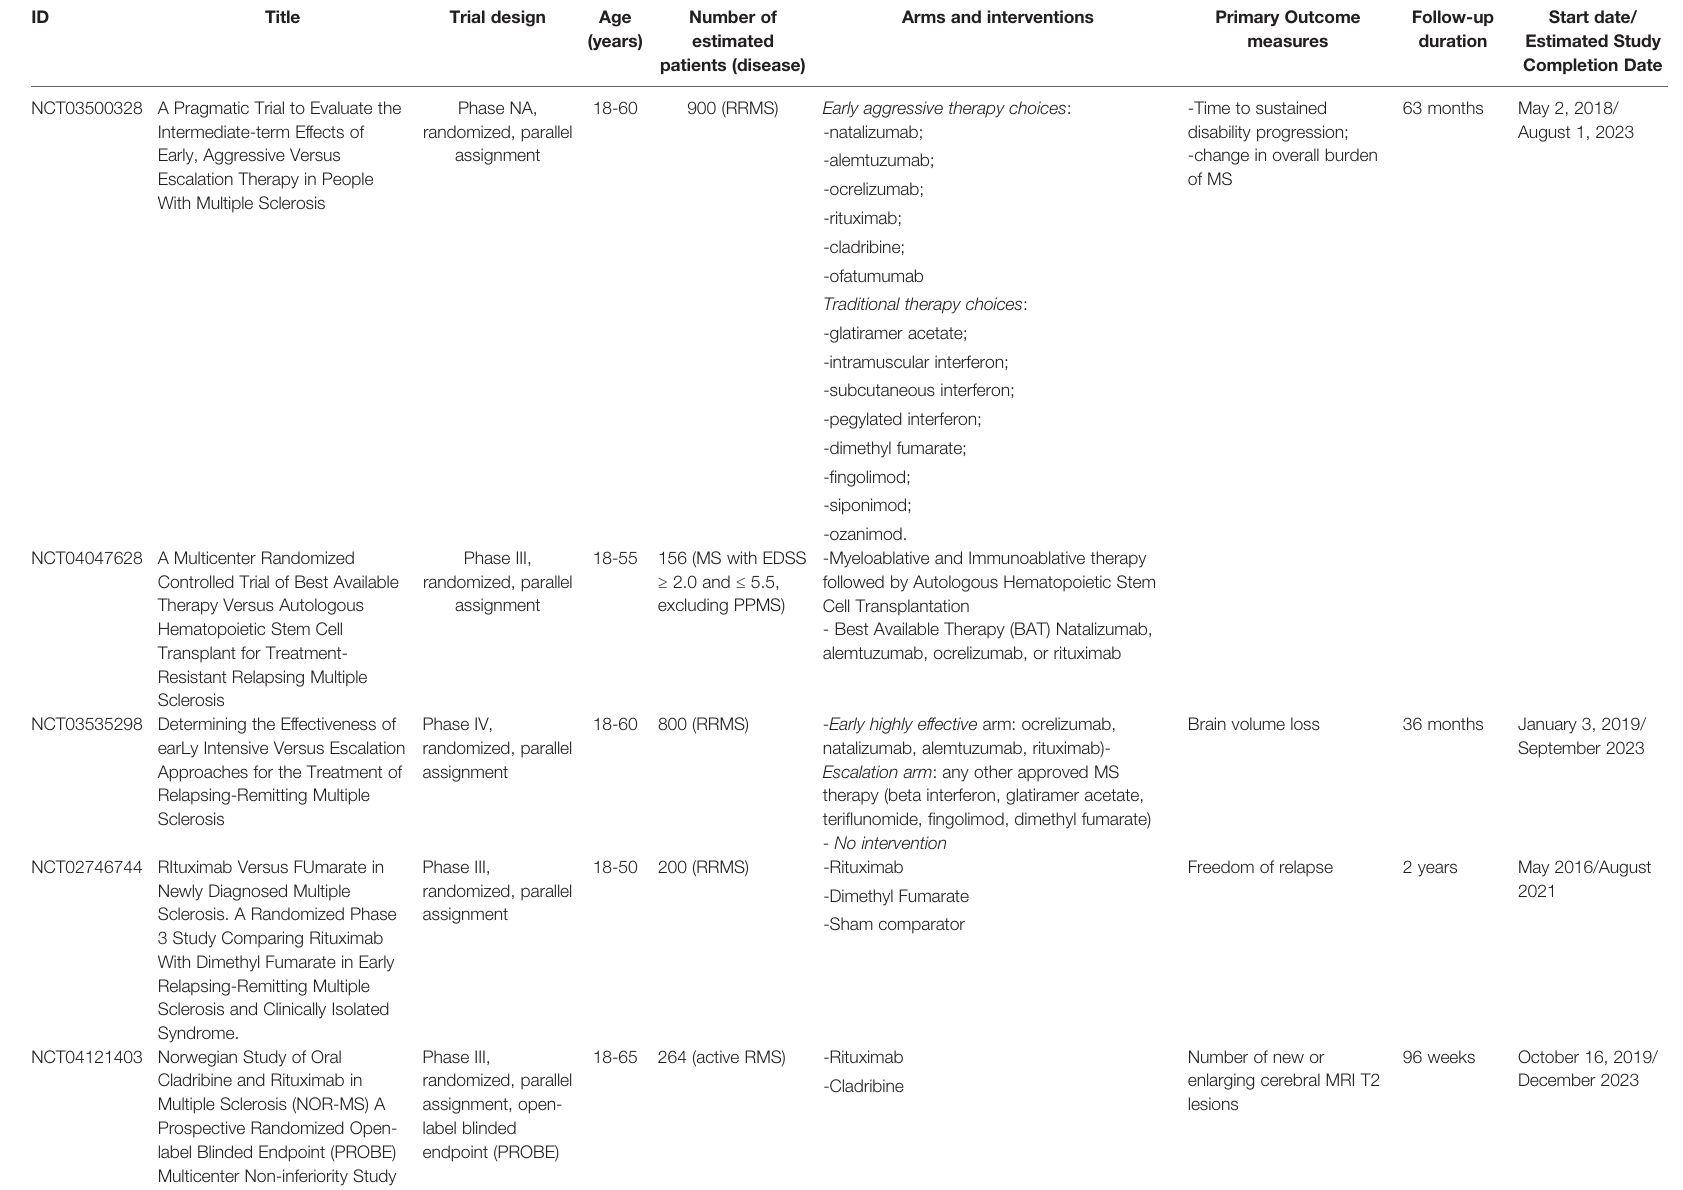
TABLE 2 | Ongoing clinical studies comparing disease modifying therapies, including rituximab (www.clinicaltrial.gov; update January 2021).